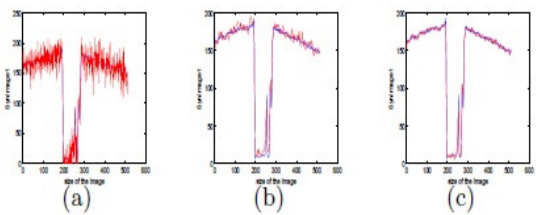
Fig. 6: The 110 th Line of True Image “Synimage1” Comparison with 110 th line of noisy image, restored by M1, and restored by M2 Images, respectively. (a) True and noisy images lines; (b) True and obtained images lines by M1; (C) True and obtained images lines by method M2. where the blue and The red lines show the true and restored images.